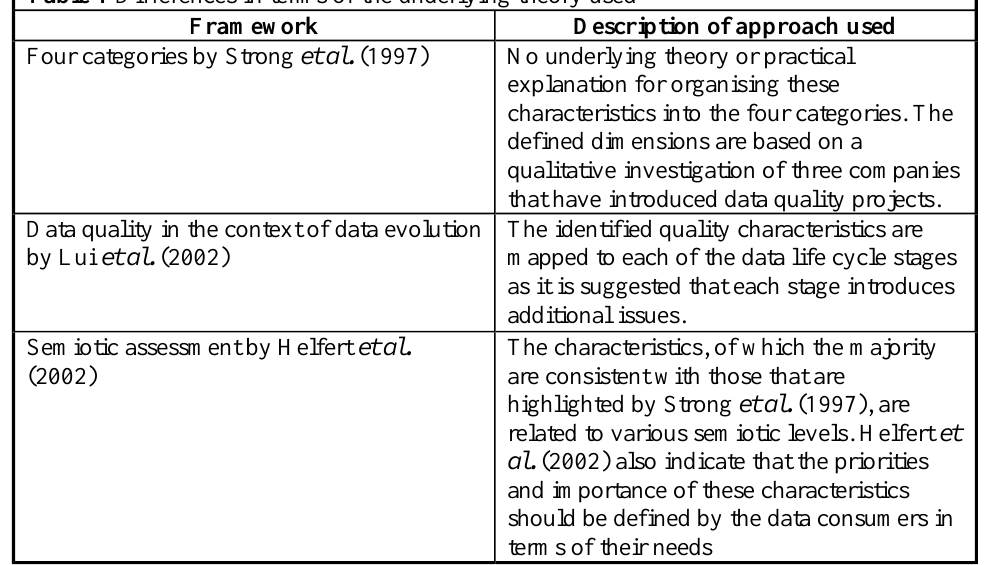
Table 1 Differences in terms of the underlying theory used Framework Description of approach used Four categories by Strong et al.